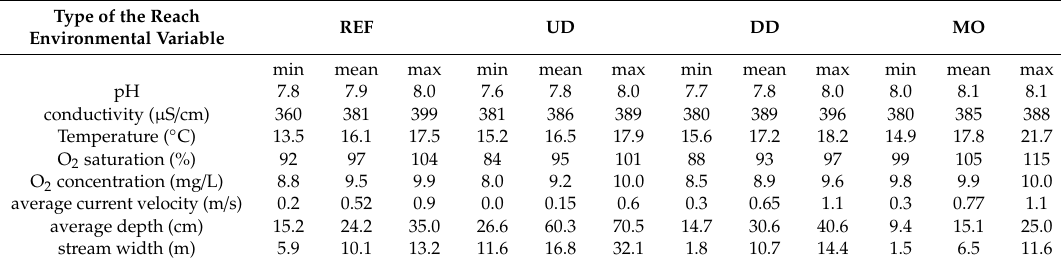
Table 1. Minimal, mean and maximal values of measured abiotic factors on sampling sites in specific types of river reach, according to their rate of hydromorphological alteration. REF—reference sites, UD—sites upstream dam, DD—sites downstream dam, MO—morphologically most altered sites—channelized and paved with stones and / or